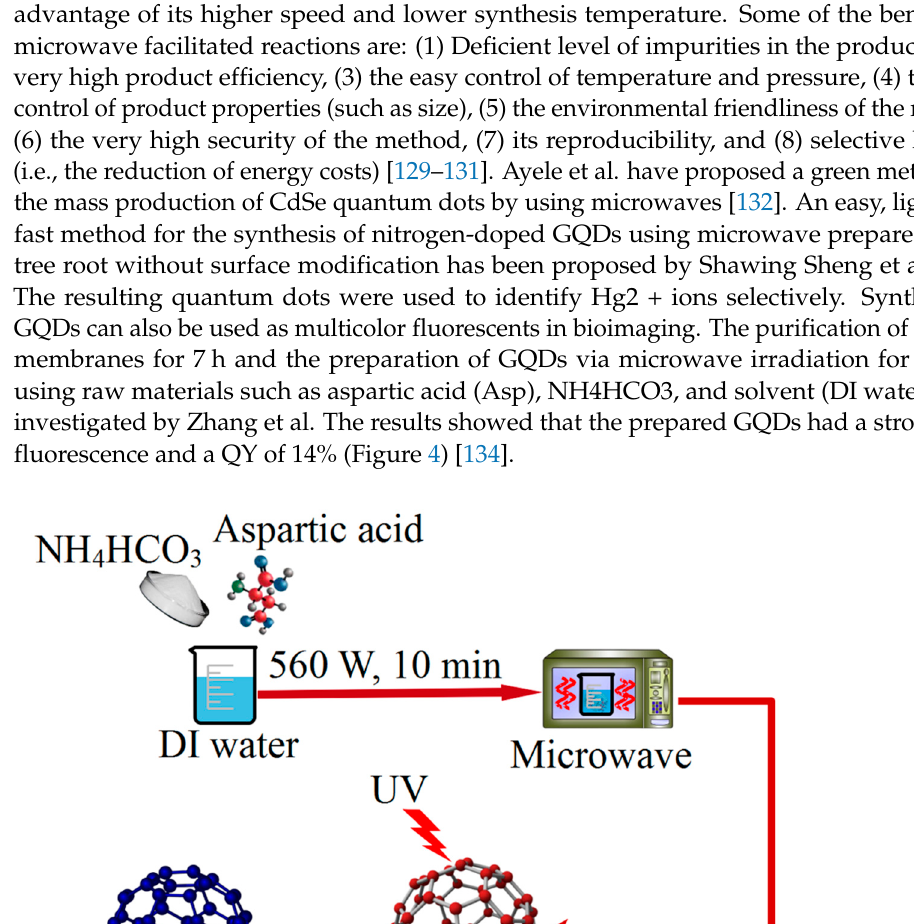
Figure 5. The synthesis method of electrochemical oxidation.